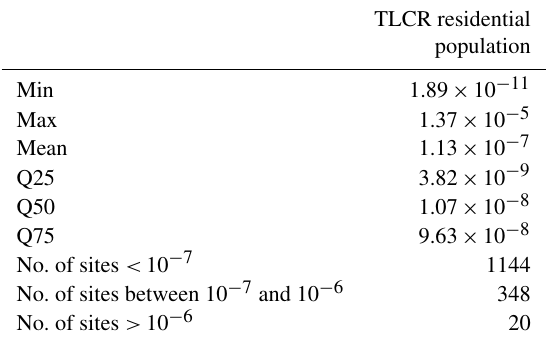
Table 7. Summary of the total lifetime cancer risk (TLCR) at- tributed to French soils for the residential